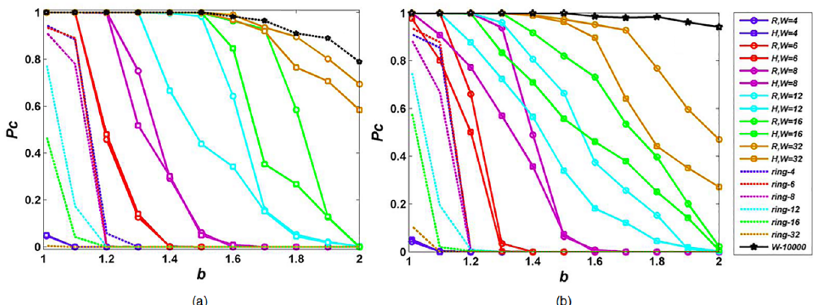
Fig 2. Density of cooperators P C on scale-free networks as a function of defection temptation b for different upper-bounds W under population size (a) N = 1000 and (b) N = 10000. R and H correspond to randominteractionand high-degree interaction, respectively.The result on corresponding regular ring- W networksis denotedby the dotted line with the same color.